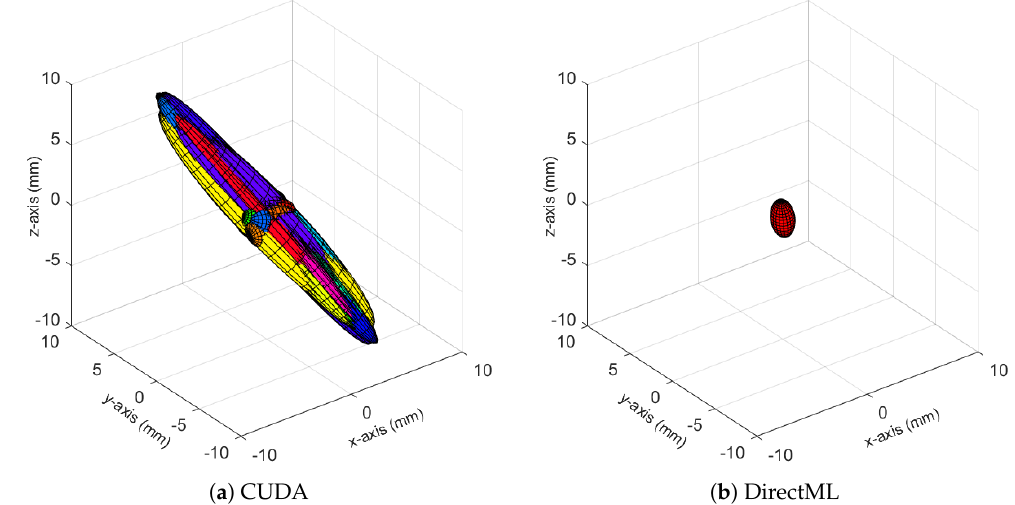
Figure 8. Ellipsoids of the joint position of KNEE_LEFT for relevant processing modes (Figures for all processing modes are shown in Figure A4). The different colors represent different body tracking